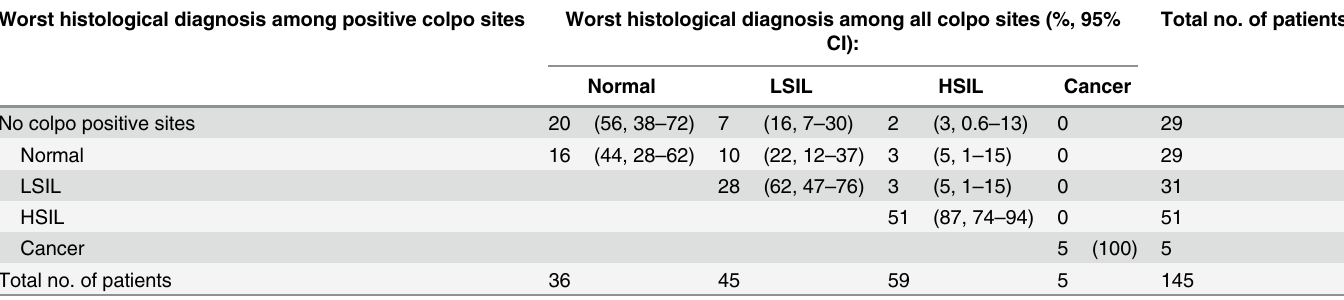
Table 6. Comparison of worst histological diagnosis among sites diagnosed as positive by colposcopy with worst overall histological diagnosis for the 145 Houston diagnostic patients with a positive Papanicolaou smear diagnosis. Worst histological diagnosis among positive colpo